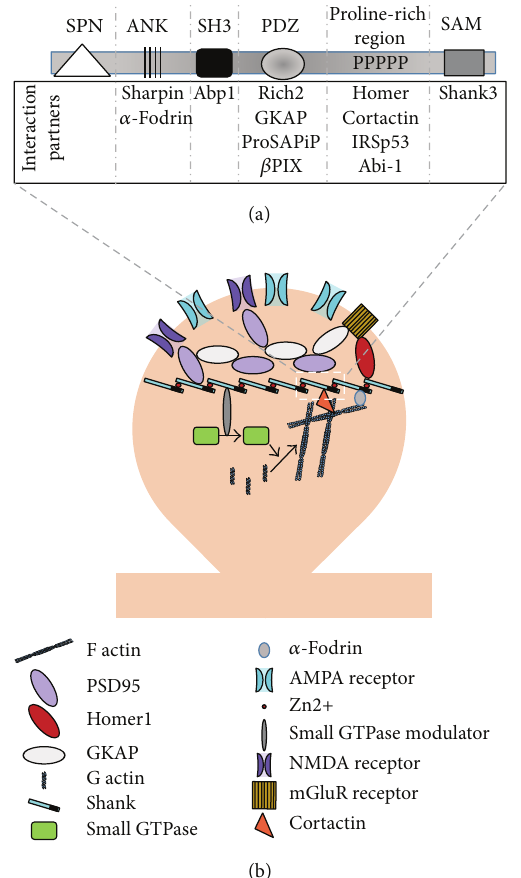
Figure 5: Cross talk between Shank and small GTPases. (a) The domain architecture of Shank proteins and their interaction partners. The Shank protein consists of 5 different important domains: N-terminal ankyrin repeats, Src homology domain 3 (SH3), PSD-95/Dlg/ZO-1 domain (PDZ domain), proline-rich region, and C-terminal sterile alpha motive. Different proteins can interact with different domains. For example, the C-terminus of GKAP, small GTPase modulator 𝛽 PIX, ProSAP interacting protein (ProSAPiP), and the C-terminal STAV motif of RICH2 can interact with the PDZ domain of Shank3. Between the PDZ domain and SAM domain, there is a gap of more that 1000 residues, which is proline-rich. This proline-rich region can interact with Homer, IRSp53, Abi-1, and cortactin. The SAM domain of Shank2 and Shank3 can bind with other SAM domains upon zinc sequestration organizing platforms in an antiparallel manner. (b) Within the dendritic spine, Shanks interact with a wide range of proteins, for example, linking other scaffolding molecules like PSD-95, Homer, and GKAP and associated receptors to the actin cytoskeleton. Some of Shank’s interaction partners are modulators of small GTPases; thereby they can activate actin remodeling via GTPase signaling. The interaction partners cortactin and 𝛼 -fodrin can stabilize actin. Such actin reorganization alters the morphology and maturity of spines and strengthens synaptic